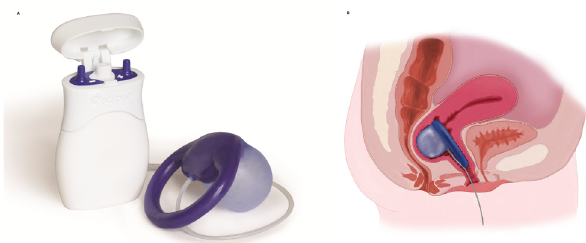
Figure 2. Vaginal bowel control system. The vaginal bowel control insert, folded and deflated for insertion (right) and inflated as it would sit in the vagina; the insert is inflated with a handheld pressure-regulated pump. Reprinted with permission from Pelvalon Inc. (Sunnyvale, CA,